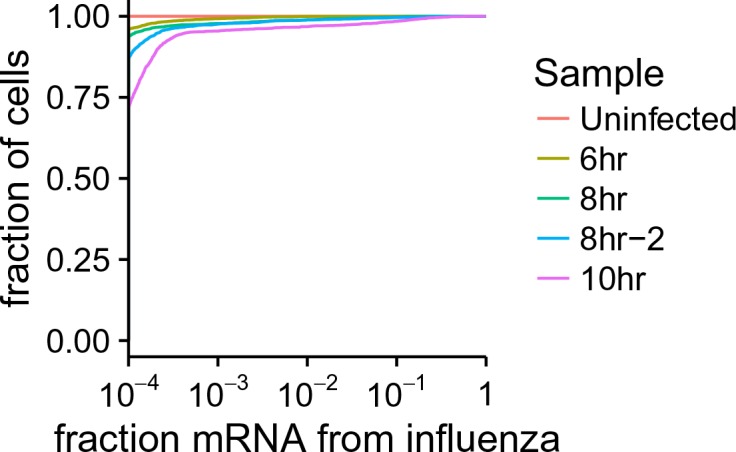
Cumulative fraction plot of proportion of total mRNA from virus.For each sample, this plot shows the fraction of all cells that derive at least the indication fraction of their mRNA from influenza virus.